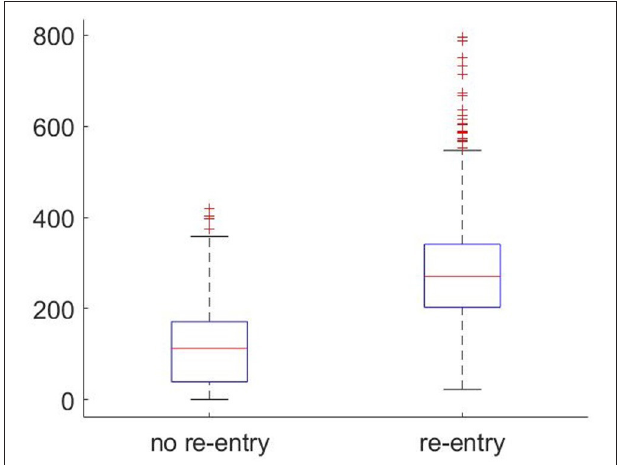
FIGURE 5 | Boxplots showing the frequency of microstructures that selectively block condution (as detected by significant negative RVI) occurring in large-scale fibrotic realisations that did or did not exhibit re-entry. The higher the number of such discriminative structures found, the more likely a re-entrant AP will survive and then escape into the surrounding